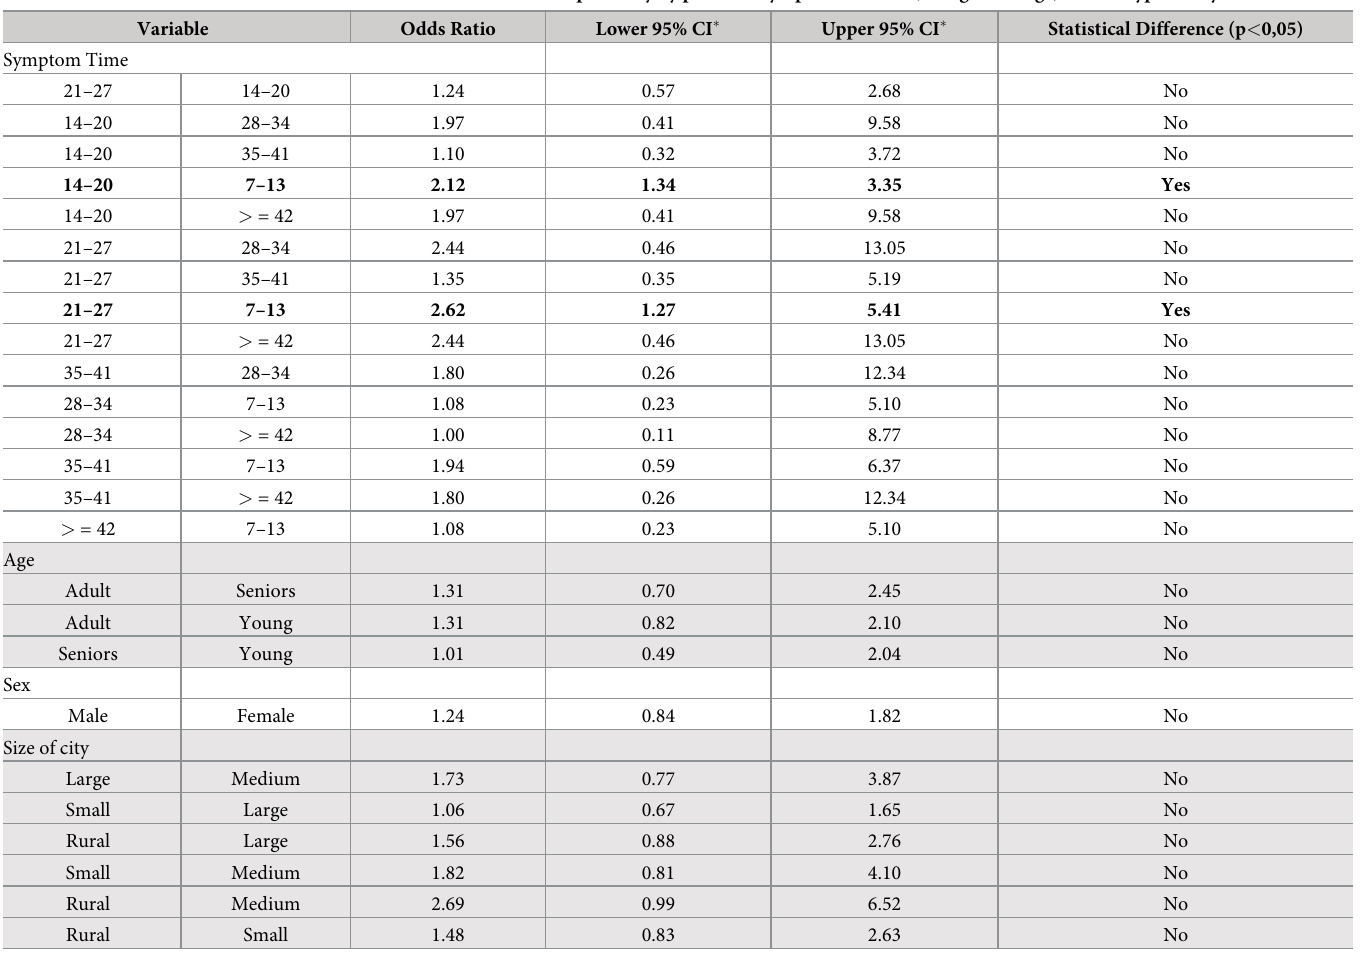
Table 5. Odds Ratio and 95% Confidence Interval for C . burnetii seropositivity by patients´ symptom duration, categorized age, sex and type of city of residence.